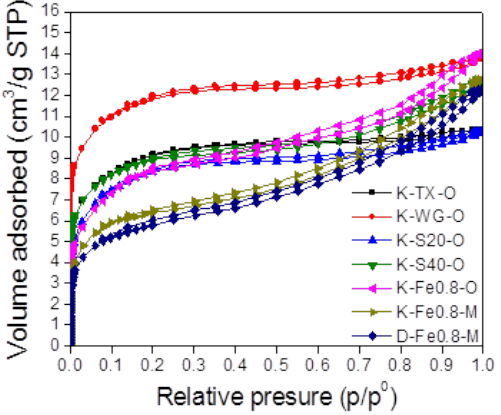
Figure 1. N 2 adsorption/desorption profiles for the samples of K-TX-O, K-WG-O, K-S20-O, K-S40-O, K-Fe0.8-M, and K-Fe0.8-O.